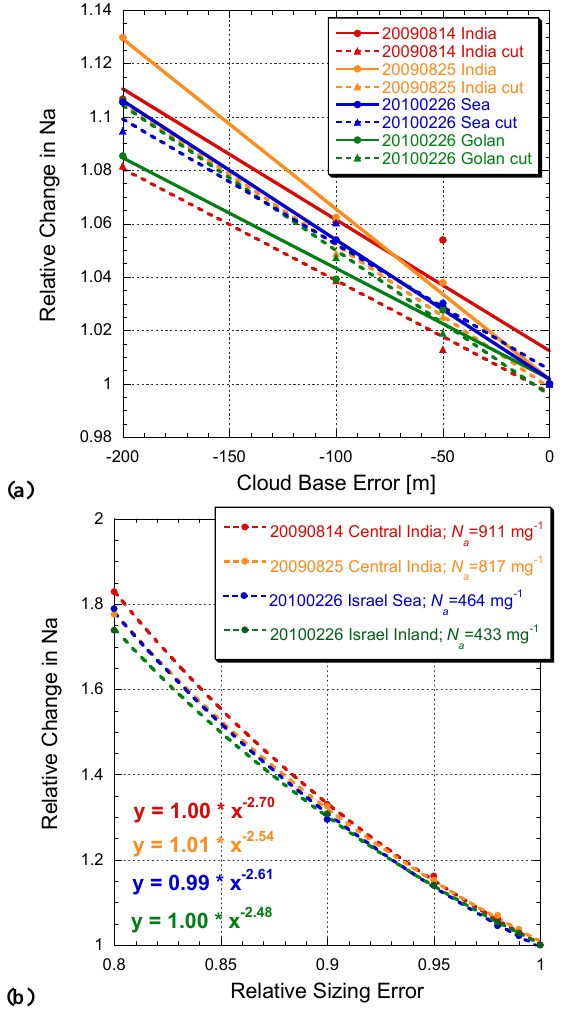
Fig. 6. Sensitivity tests: (a) The relative change in N a due to un- certainties in cloud base altitude for four different cases (flights 20090814 and 20090825 over central India and two profiles from flight 20010226 over Israel, one over the sea and one ∼ 70km in- land). The change in cloud base altitude causes changes in the cloud base pressure and temperature, and hence modifies the pro- file of LWC a . This affects R v and AF and eventually N a . The a filled circles and solid linear best fit curves mark that N a derivation was based on the full profile, while the filled triangles and dashed lines mark that the data from the first kilometer above cloud base were filtered out before N a was derived. This suggests that when there is no data available from the lower part of the profile, N a can be derived with the same confidence as when all data is available. (b) The relative change in N a due to uncertainties in the sizing of the cloud droplets by the cloud droplet spectrometer. The same cases as in (a) are presented with the derived (original) N a values for each case in the legend, before the errors were introduced. The dashed lines denote the best power fit for each case and show fairly high sensitivity of the derived N a to sizing